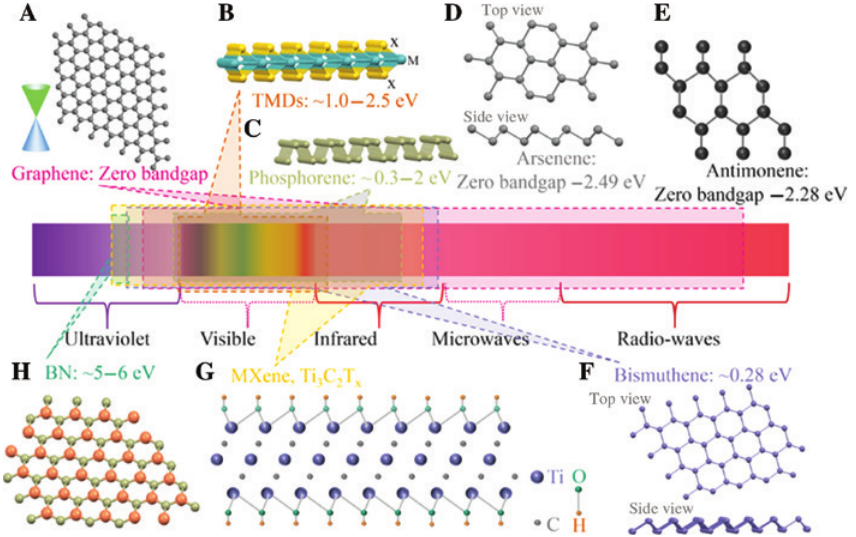
Figure 2: The atom structure and spectral region of 2D materials. The atom structure and spectral region of 2D materials such as graphene (A), TMDs (B), phosphorene (C), arsenene (D), antimonene (E), bismuthene (F), MXene (G), and BN (H). Copyright 2019, Wiley-VCH. Reproduced with permission